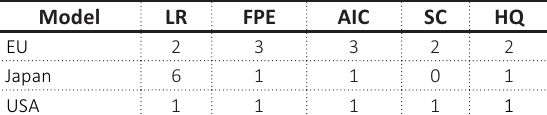
Table 2. Test results for the length of the lag in models